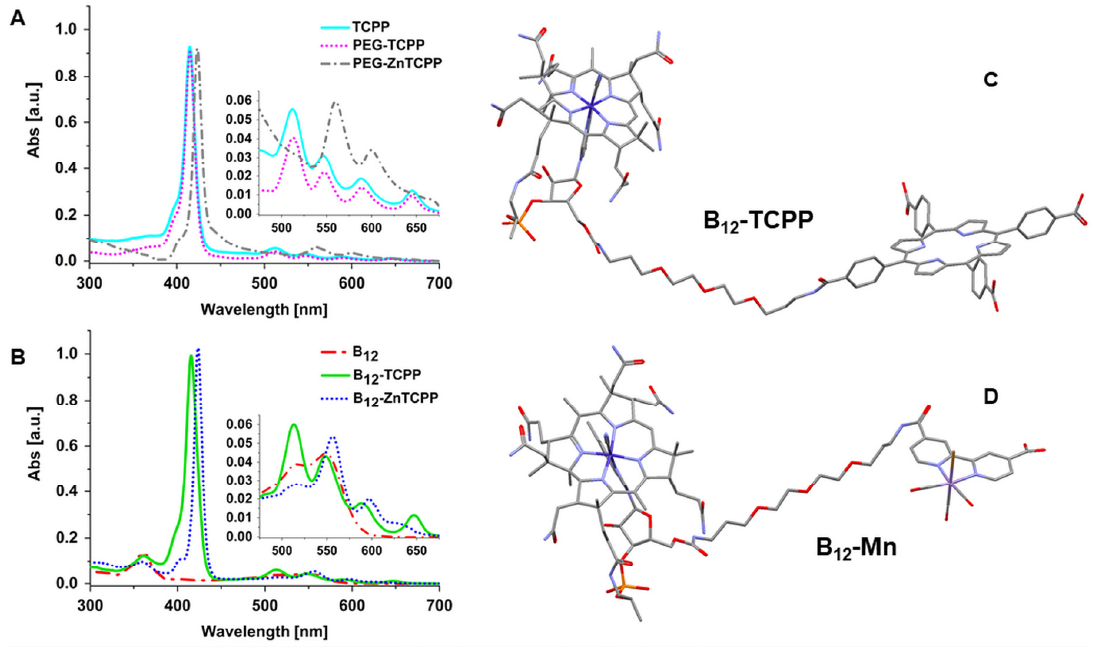
Figure 3. ( A , B ) represent the UV-Vis absorption spectra of TCPP, PEG-TCPP, PEG-ZnTCPP and Figure 3 B 12 , B 12 -TCPP, B 12 -ZnTCPP, respectively; ( C , D ) show optimized structures of B 12 -TCPP and B 12 -Mn, respectively, calculated in silico by Density functional theory (DFT) (polarizable continuum model with water as solvent). C-atoms are grey, N-atoms blue, O-atoms red, P is orange and Co dark blue. H-atoms are omitted for